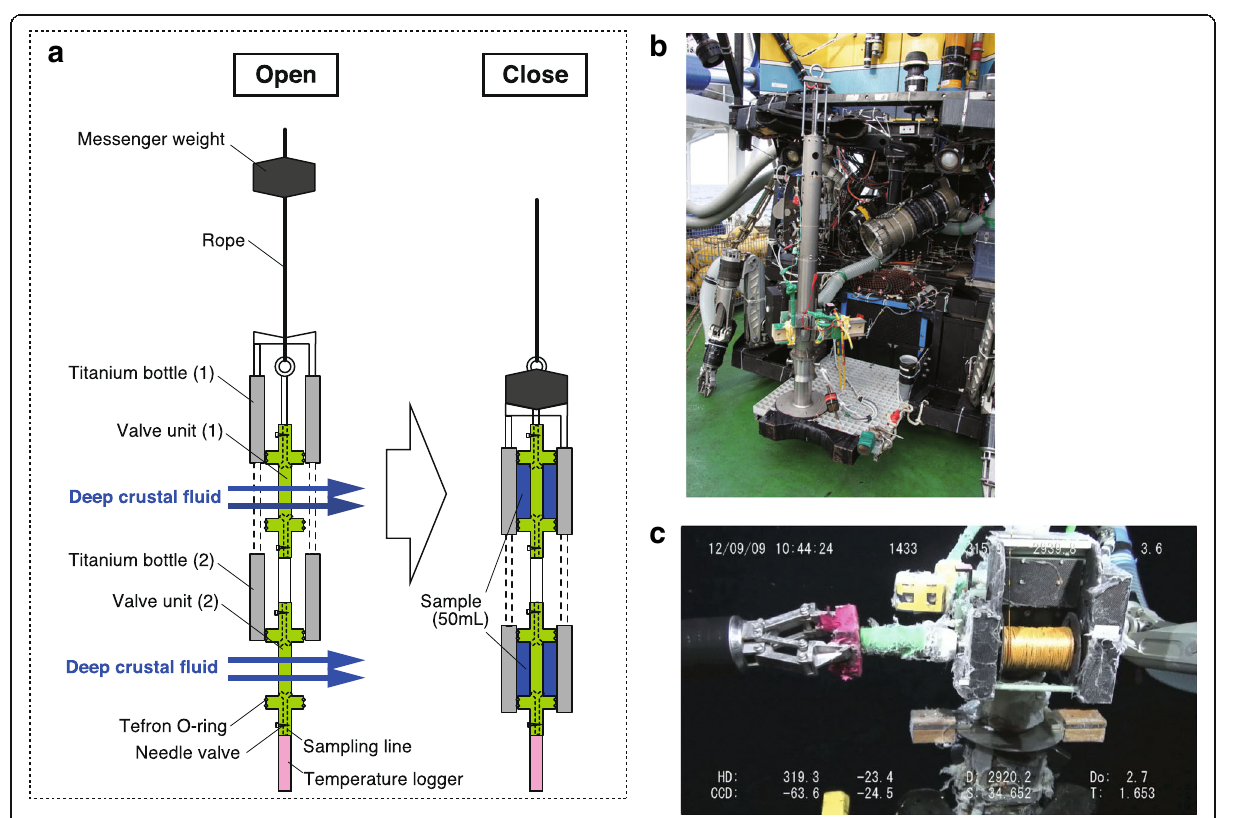
Fig. 2 A schematic illustration and photographs of the “ Deep Sampler ” used for CORK fluid sampling. a The open titanium bottle, chamber, and valve units were lowered to the screened depths (170 mbsf) through the cased hole. Then, a messenger weight was dropped from the seafloor along the rope, resulting in closing the bottle unit to the chamber-valve unit for fluid sampling. b A photograph showing the Deep Sampler being prepared in the payload of the ROV Hyper-Dolphin. c A photograph showing the on-site operation of the Deep Sampler from 170 mbsf